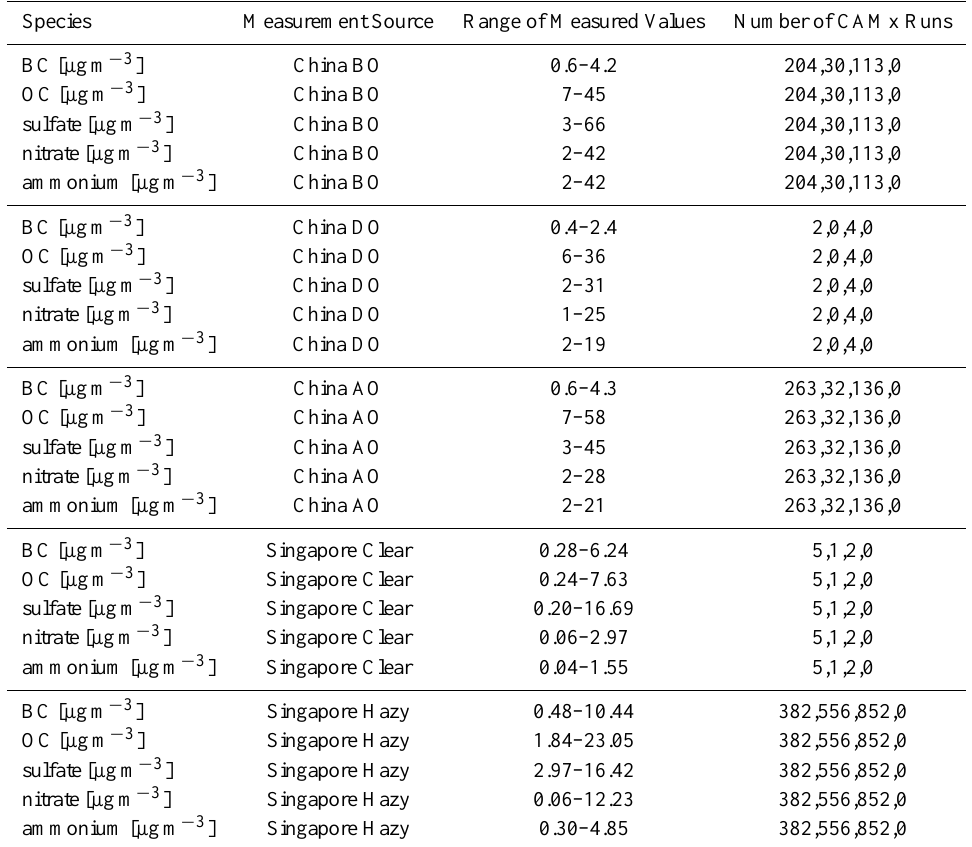
Table 8. A comparison of CAMx parent model runs that successfully simulate the mass concentrations of (BC, OC, sulfate, nitrate, and ammonium) within the corresponding measured daily average ranges, based on campaigns in Beijing (1) (Huang et al., 2010) and Singapore (2) (See et al., 2006). The range of measured values given is the spread from minimum to maximum measured daily average concentration under the conditions given under the measurement source column. The number of CAMx model runs corresponds to the total number of runs in which all 5 chemical species were simultaneously modeled within the bounds given by the measurements. The four numbers correspond to the meteorological types, in the same order as given in Table 1. The PDFs of the underlying distribution as a function of model concentration are are given in Figs. 6 and